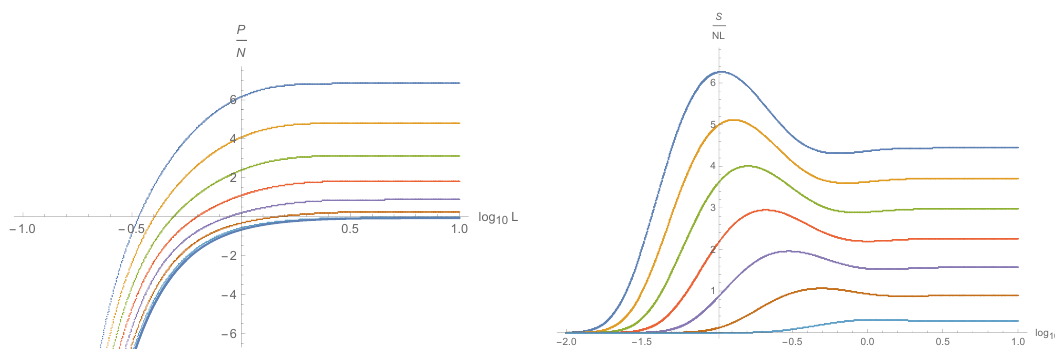
Figure 3 . Pressure and entropy density for (cid:3) = 1 ; M = 0 and T = 0 ; 0 : 5 ; 1 ; : : : ; 3 : 5, from the bottom to the